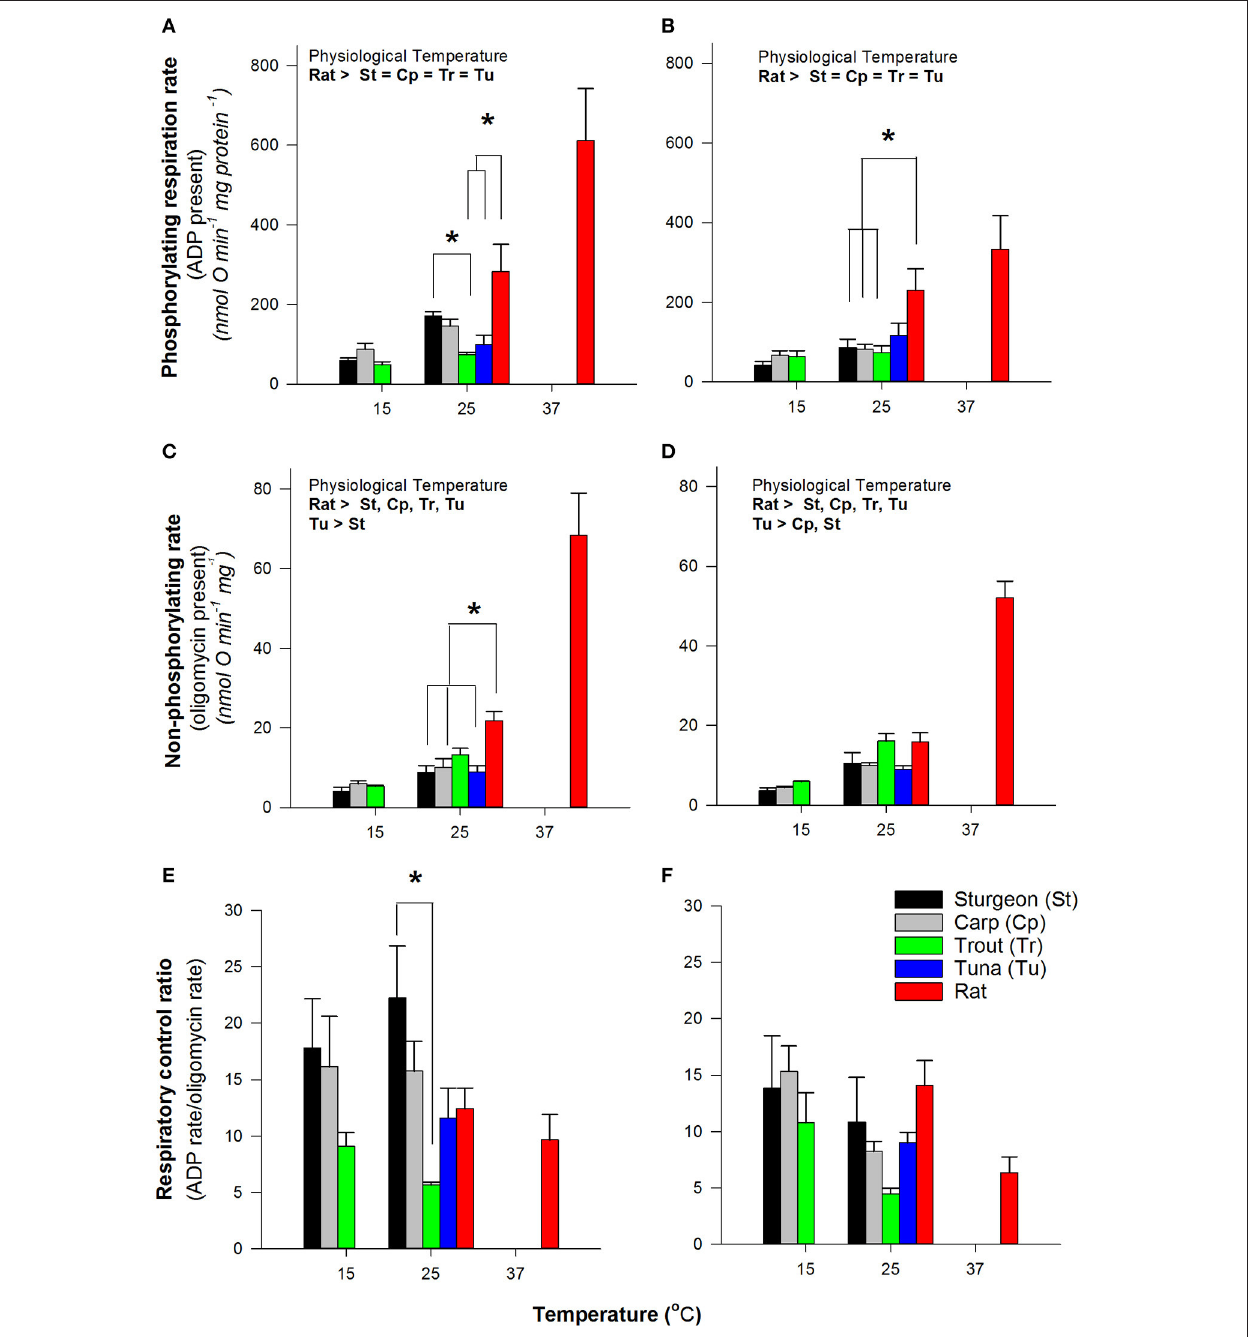
FIGURE 2 | Comparison of respiration rates by isolated muscle mitochondria. Data are mean ± SEM ( n = 3–5 depending on species) and substrates were 5 mM pyruvate and malate (A,C,E) or 0.05 mM D/L-palmitoylcarnitine and 5 mM malate (B,D,F) . Assay temperature is indicated and contrasts were made at a common temperature (indicated by * and brackets) or physiological temperatures as indicated within figures. Physiologically relevent temperatures are 15 ◦ C for sturgeon, carp and trout; 25 ◦ C for Bluefin tuna; 37 ◦ C for rat.